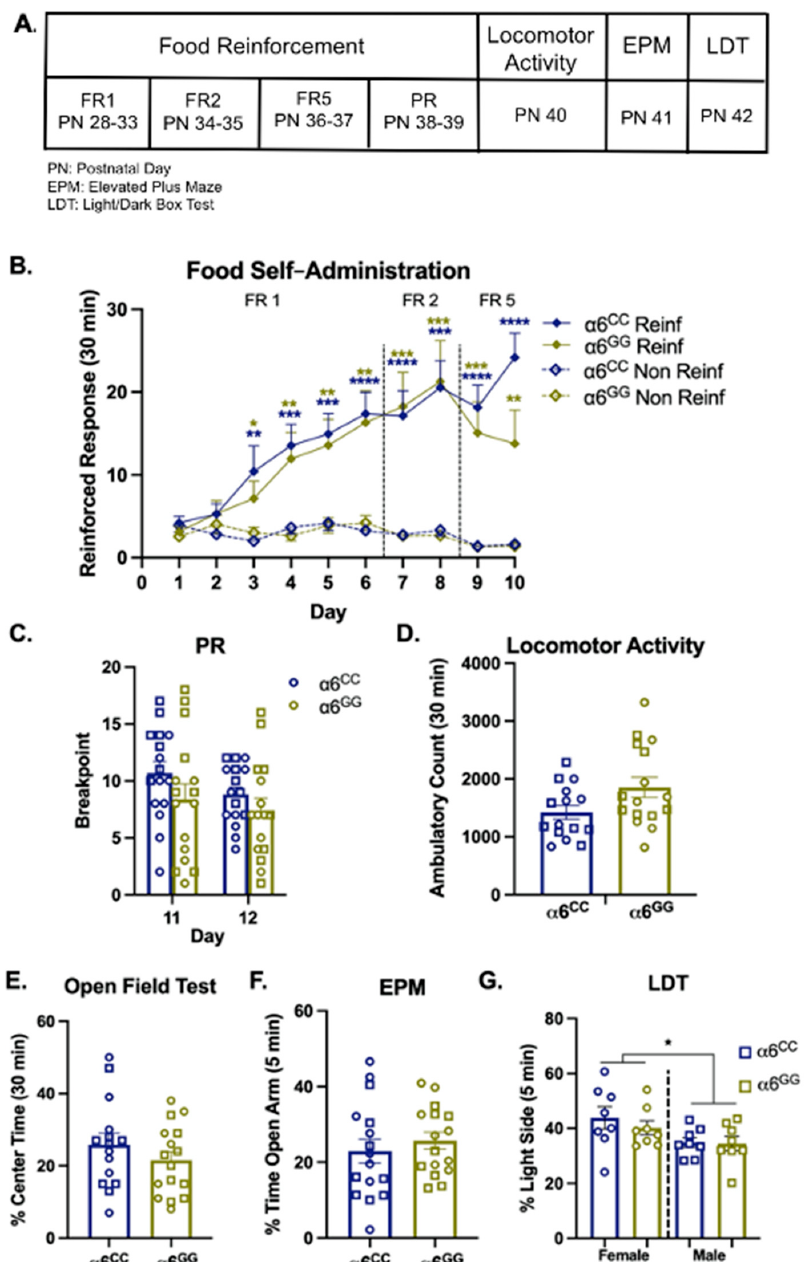
Figure 2. The human CHRNA 6 3 ′ -UTR knock-in does not impact baseline behavior. ( A ) Experimental paradigm for baseline behaviors. Postnatal Day (PN), Elevated Plus Maze (EPM), and Light/Dark Box Test (LDT). ( B ) Mean daily 30 min response ± SEM for food self-administration at Fixed Ratio (FR)1, FR2, and FR5 schedules of reinforcement, n = 16/group. **** p < 0.0001; *** p < 0.001; ** p < 0.01; * p < 0.05 Reinforced (Reinf) vs. Non-Reinforced (Non Reinf) responses. ( C ) Mean breakpoint ± SEM for food self-administration under a progressive ratio (PR) schedule of reinforcement, n = 16/group. ( D ) Mean total ambulatory counts ± SEM, n = 15–16/group. ( E ) Mean percentage (%) of time spent in the center of an open field ± SEM, n = 15–16/group. ( F ) Mean % of time spent in the open arm of an EPM ± SEM, n = 16/group. ( G ) Mean % of time spent on the light side of a Light/Dark box ± SEM, n = 8/group. * p < 0.05 females vs. males. Circles represent females and squares represent